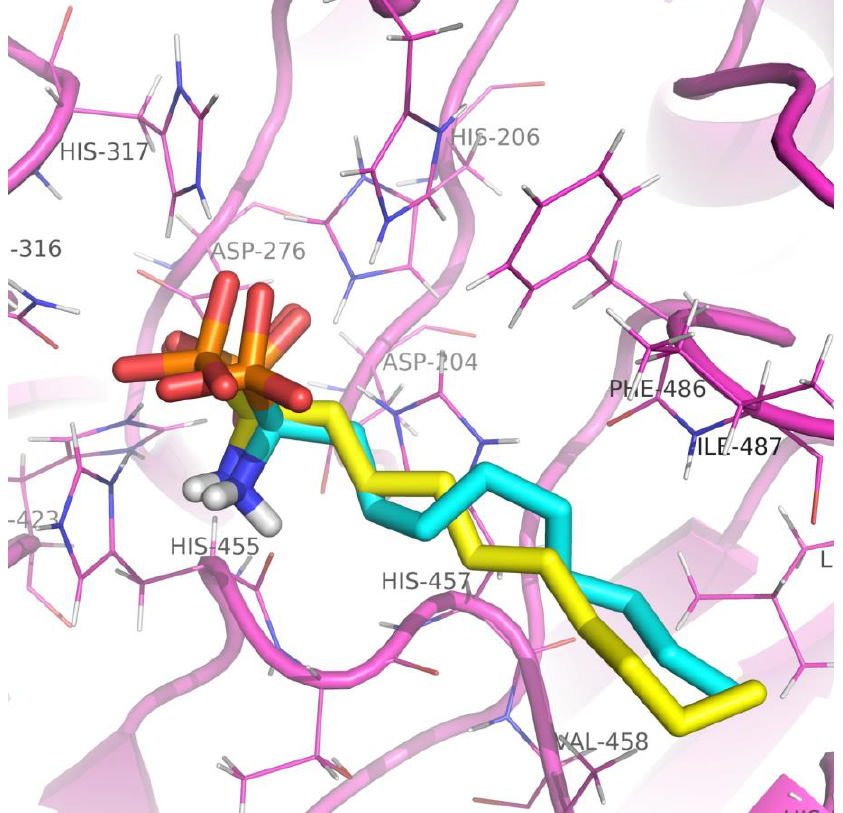
Figure 4. Three-dimensional representation of the native AbPA ligand (yellow) and docked AbPA ligand (blue) in the crystal structure of murine acid sphingomyelinase. The protein with active site residues is displayed in pink. Table 1. Table representing the top 5% drugs selected after docking (on the basis of binding affini- ties) and ADME toxicity analysis.